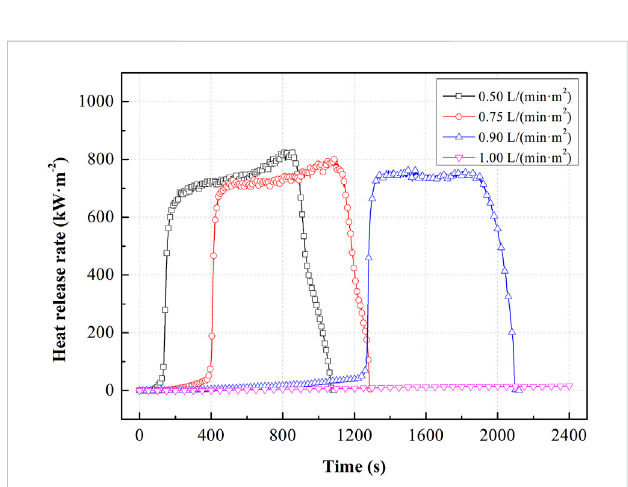
FIGURE 7 Heat release rate of test No.4 at different water mist fl ow rates under radiant heat fl ux 50 kW/m 2